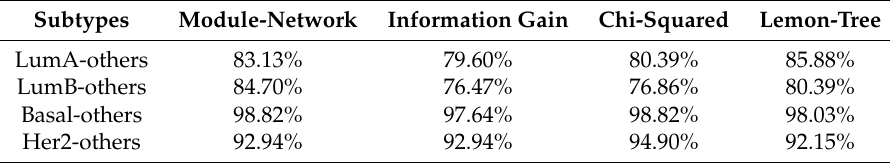
Table 1. The accuracy of 10-fold cross validation between subtypes.